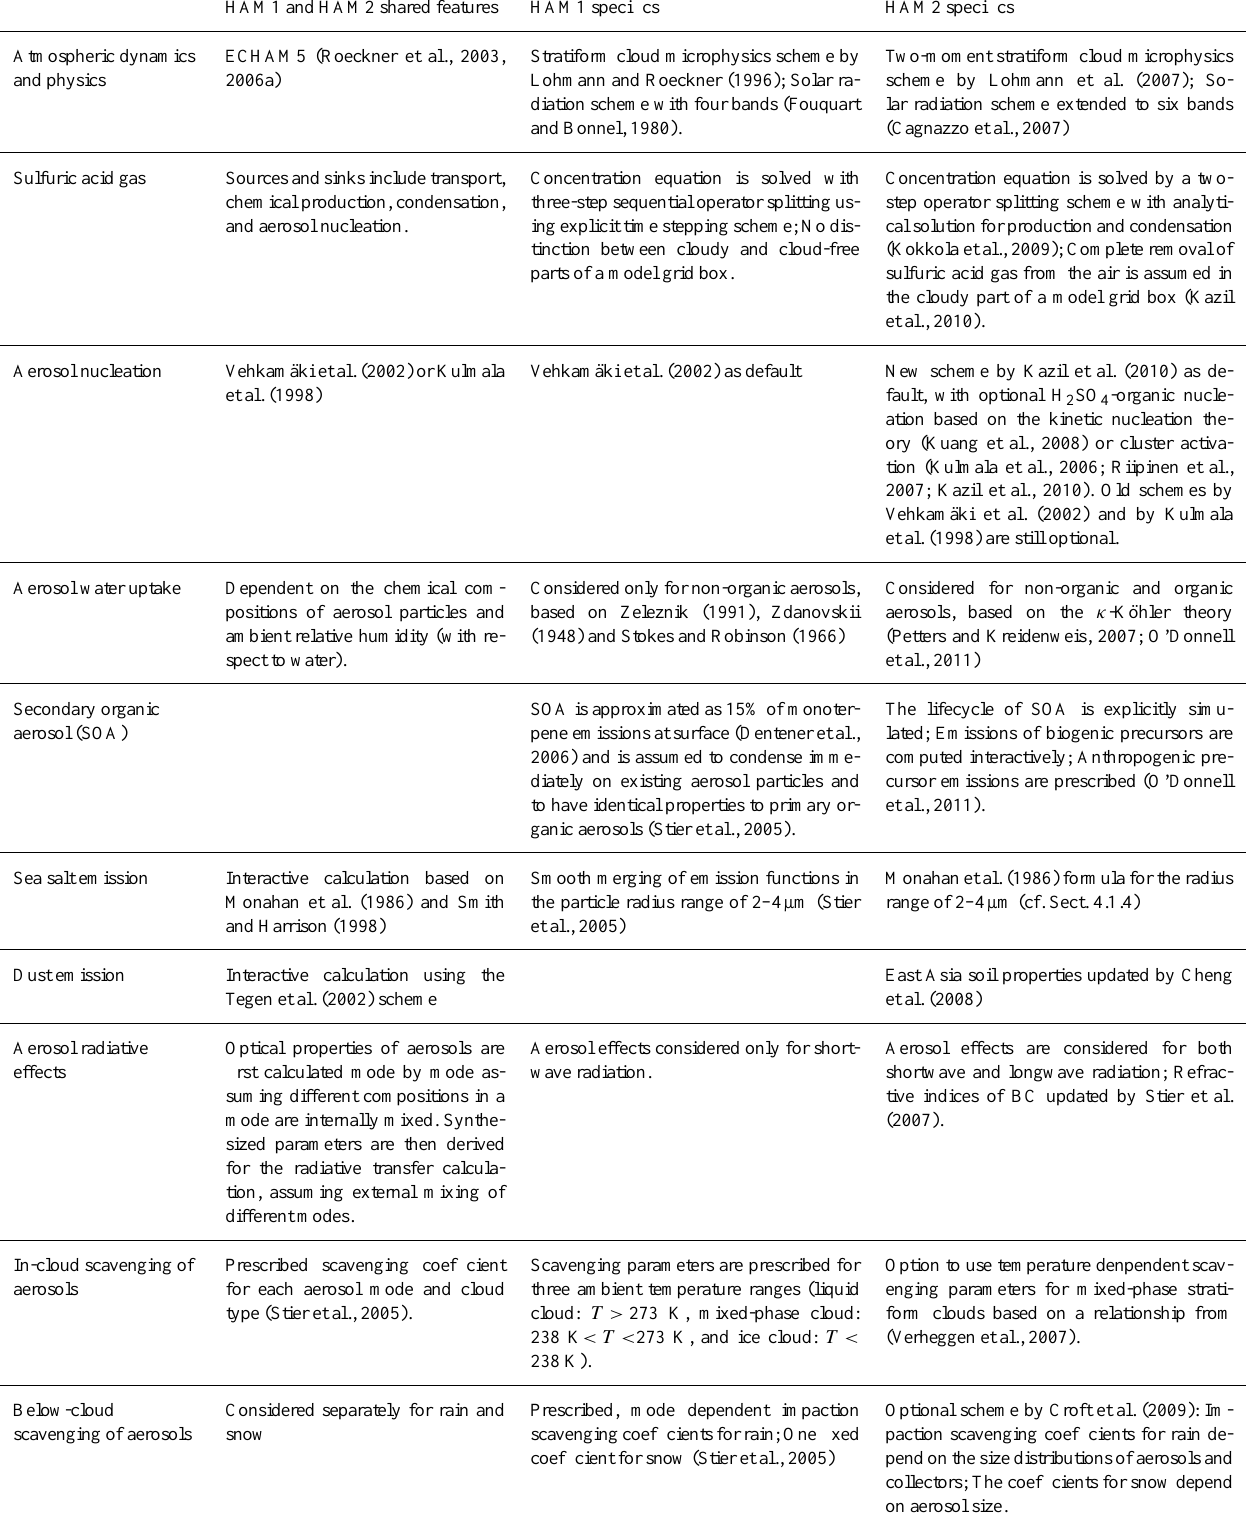
Table 1. An overview of the main differences between HAM1 and HAM2 in model